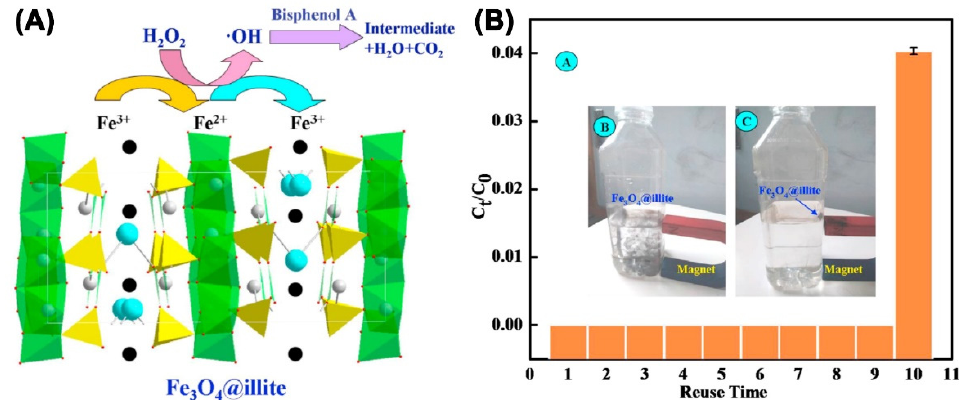
Figure 5. ( A ) Schematic illustration the catalytic activation of H 2 O 2 by Fe 3 O 4 @illite; ( B ) regeneration and reusability tendency of Fe 3 O 4 @illite application (the insert A is the catalytic activity of Fe 3 O 4 @illite in 10 successive run, the insert B and C are the illustration of separation process of Fe 3 O 4 @illite from suspension by an magnet) [83], Copyright 2021 Elsevier.